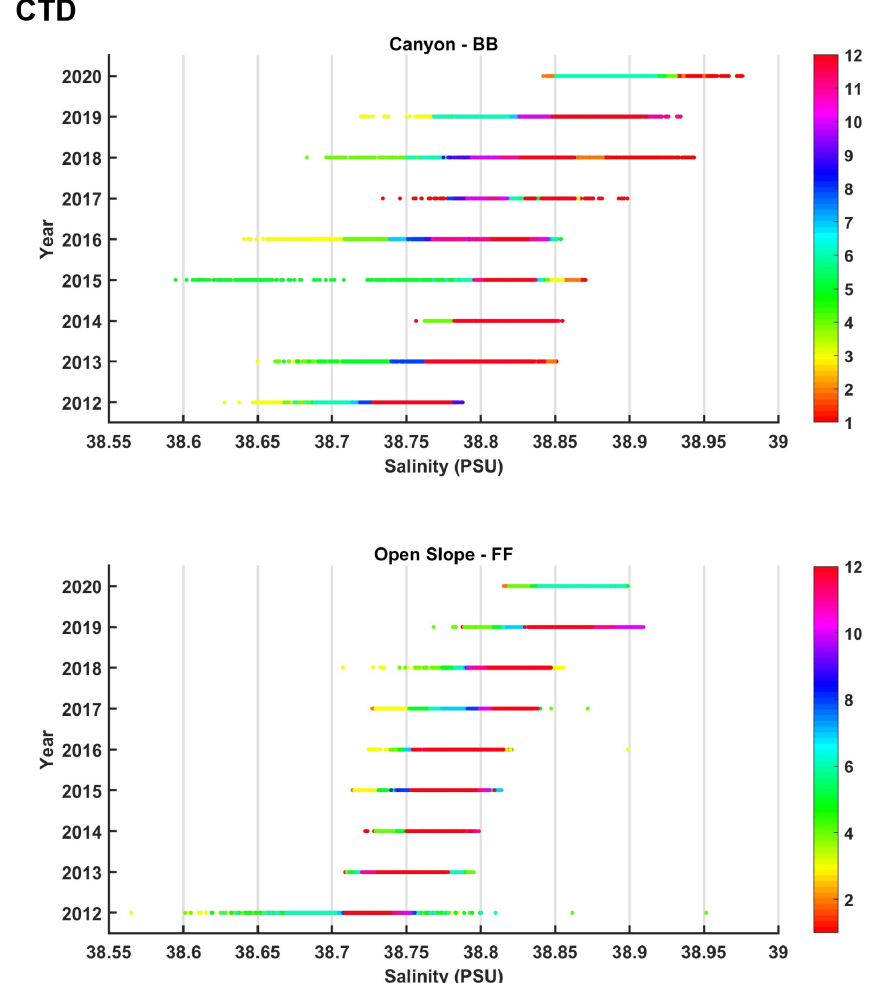
Figure 7. Scatterplot of salinity records grouped by years ( y axis) and months (colour scale).